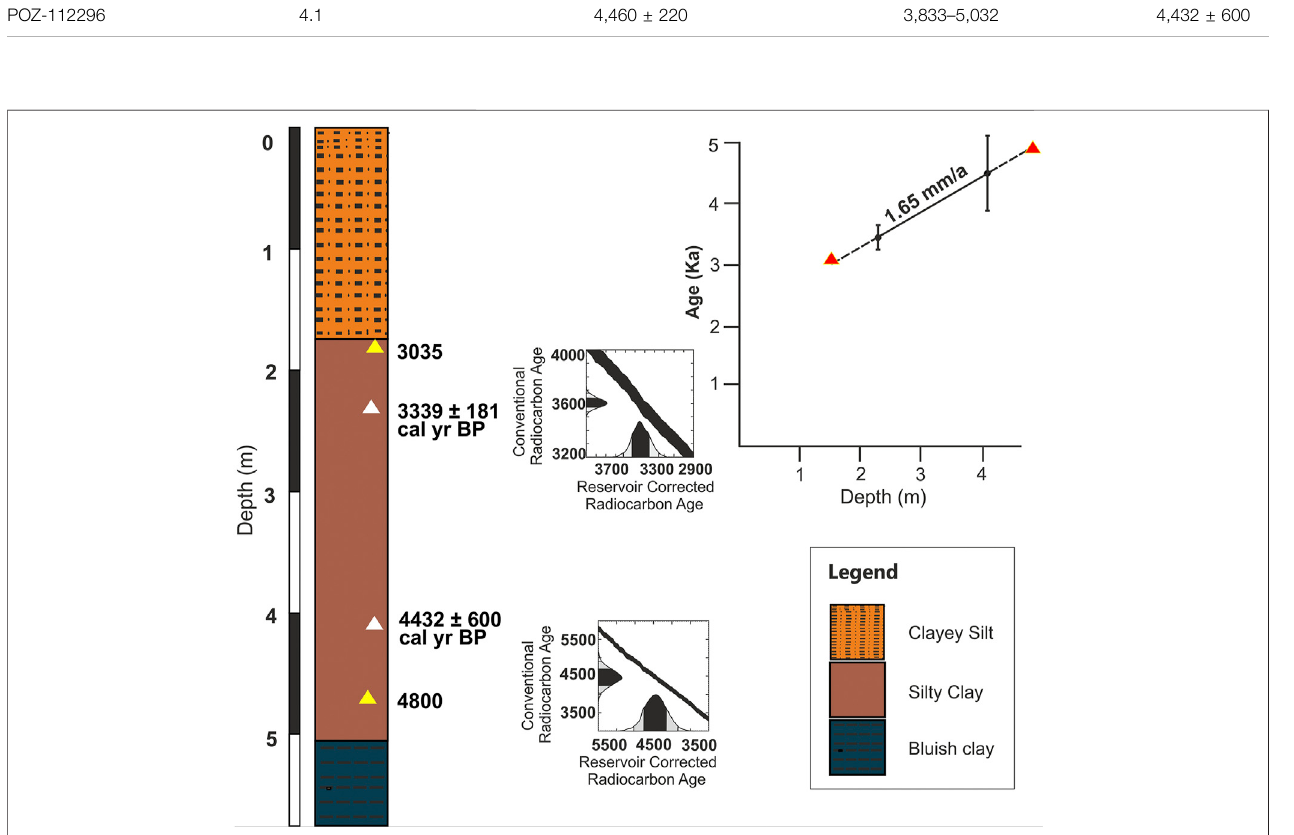
FIGURE 2 | Stratigraphy and the age depth model for the BKR trench site.